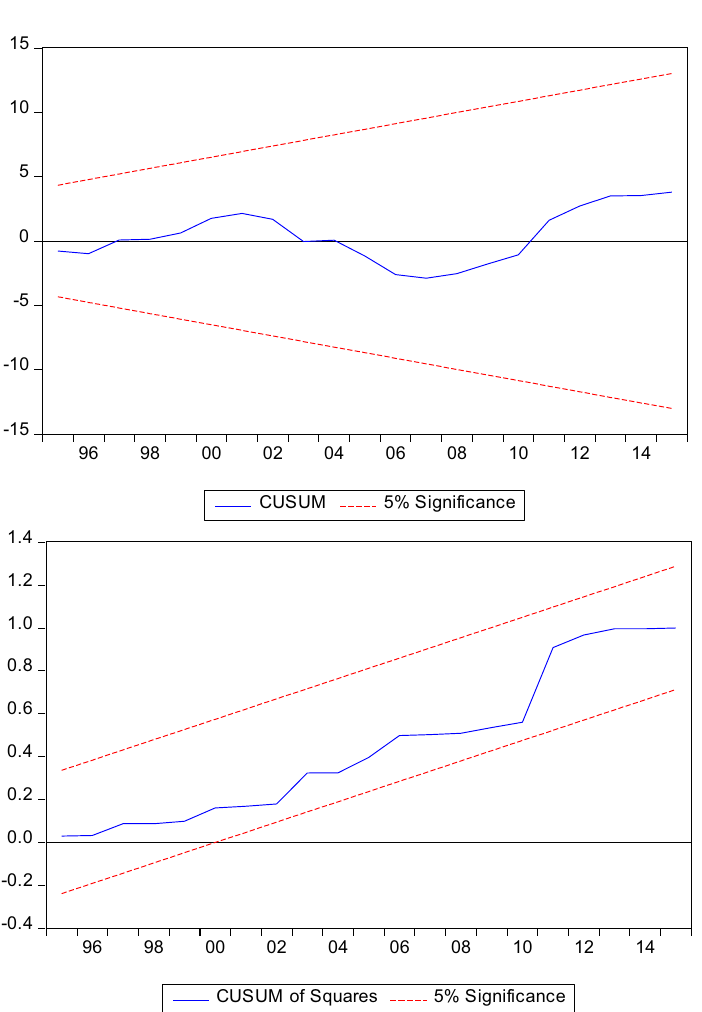
Figure A3. Plots of cusum